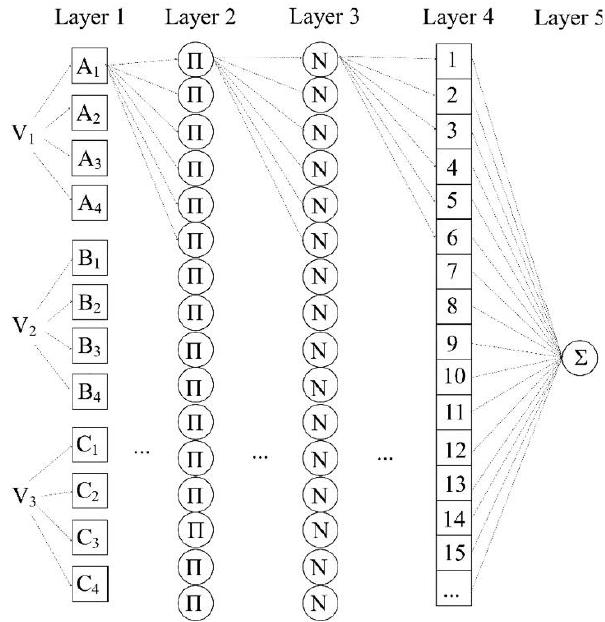
Figure 3. Example of the fuzzy reasoning mechanisms for this study using the “Multi-input” approach. V 1 , V 2 , and V 3 are input variables i.e., river flow at Jasper, Hinton, and Athabasca). A, B, and C are the membership functions for each input variable. Π represents the firing strength of the fuzzy logic rules and N is the ratio between the i -th rule firing strength and the sum of all firing strengths. ∑ is the sum of all the incoming signals from the previous node. Table 2. Overview of the Adaptive Neuro-Fuzzy Inference System (ANFIS) settings used per each model for the two different calibration – validation dataset approaches.